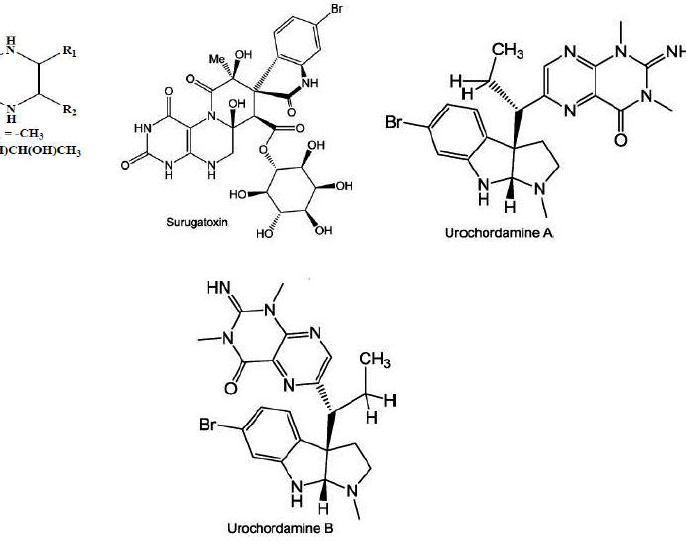
Figure 7: Natural toxic